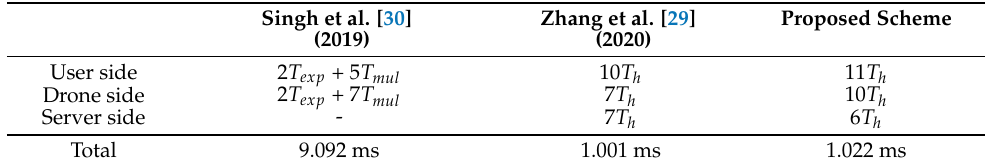
Table 3. Comparison of Computational